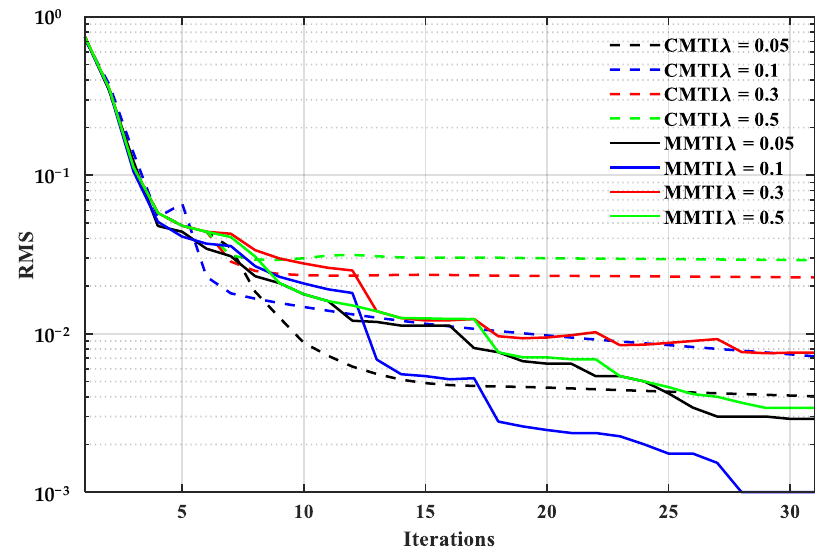
Figure 7. Comparison of inversion-convergence curves.